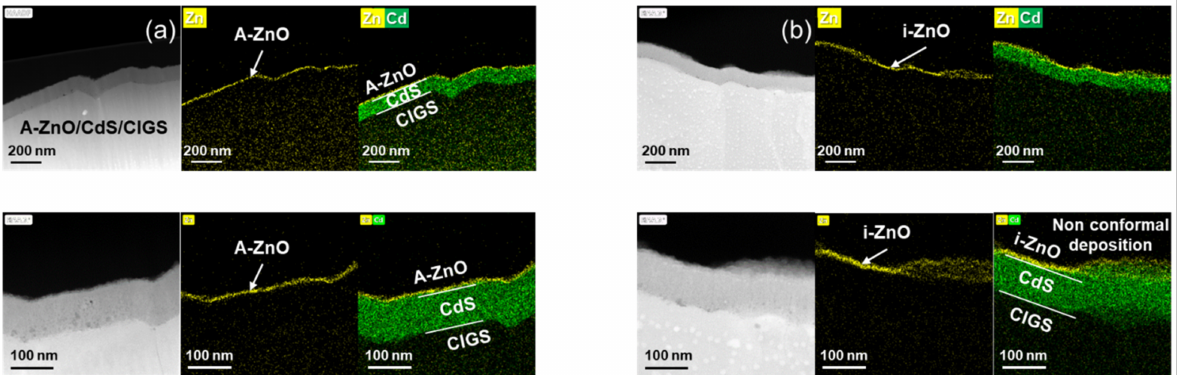
Figure 1. Cross-sectional scanning transmission electron microscopy (STEM) high-angle annular dark-field imaging (HAADF) and energy-dispersive X-ray spectroscopy (EDS) images of ( a ) atomic-layer-deposited ZnO (A-ZnO) on a CdS/CIGS surface and ( b ) sputtered intrinsic ZnO (i-ZnO) on a CdS/CIGS surface.